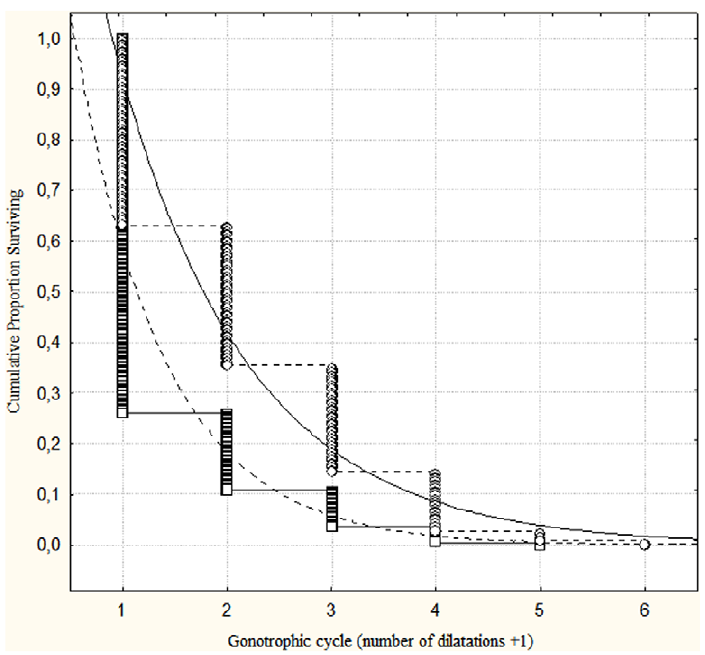
Figure 2. Kaplan-Meier cumulative proportions plot with weighted least squares exponential regression fitting for Anopheles darlingi caught in January (unbroken line and circles) and July 2004 (dotted line and squares).